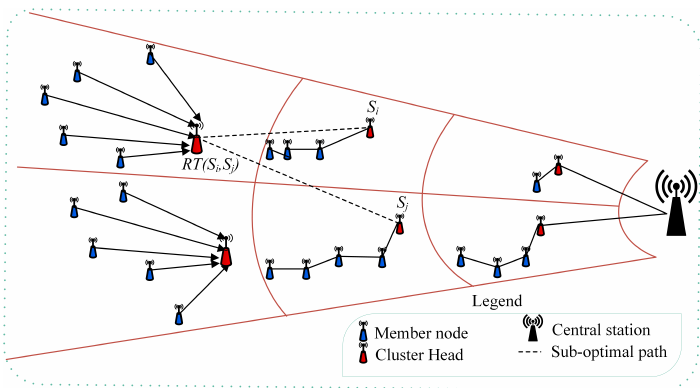
Figure 5. Description of inter-cluster sub-optimal multi-hop routing. Figure 6 is the flow chart for the inter-cluster multi-hop routing topology. Upon identifying the Cluster Head and its belonging member nodes for the current running round, the central station creates a routing table ( RT ) and next broadcasts it to the intended Cluster Head. Before transmitting the generated routing table to the network, the central station attaches a set of Cluster Head IDs to the RT and at the same time determines the cost field in the RT with value zero (i.e., Cost ( CS ) =